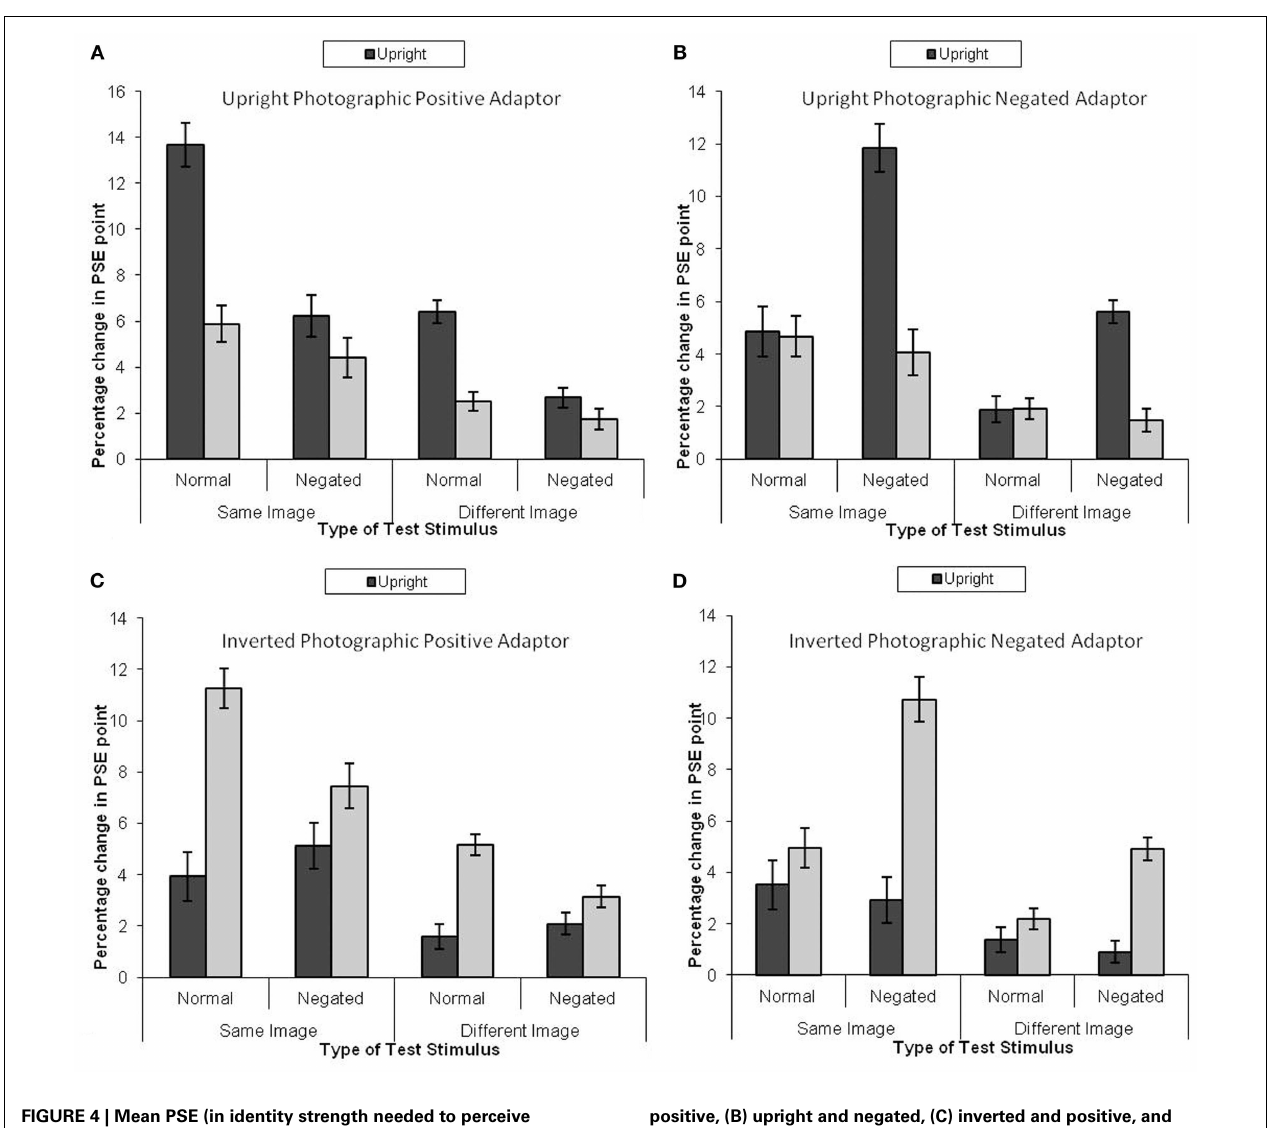
FIGURE 4 | Mean PSE (in identity strength needed to perceive the adapted identity) shift pre- to post-adaptation (as a measure of the magnitude of the aftereffect) for unfamiliar faces, when the adaptor is (A) upright and photographically